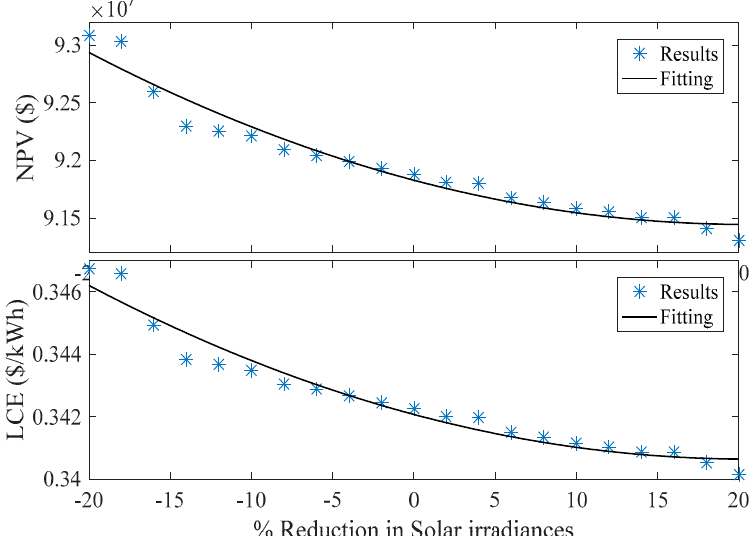
Figure 14. The variations of TPC and LCE along with ±20% change in solar irradiance.